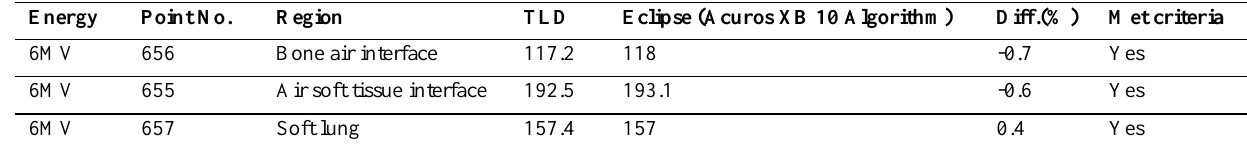
Table 1. The TLD measured doses and the Eclipse TPS calculated relative doses in the lung region Energy Point No. Region TLD Eclipse (Acuros XB 10 Algorithm) Diff.(%) Met criteria